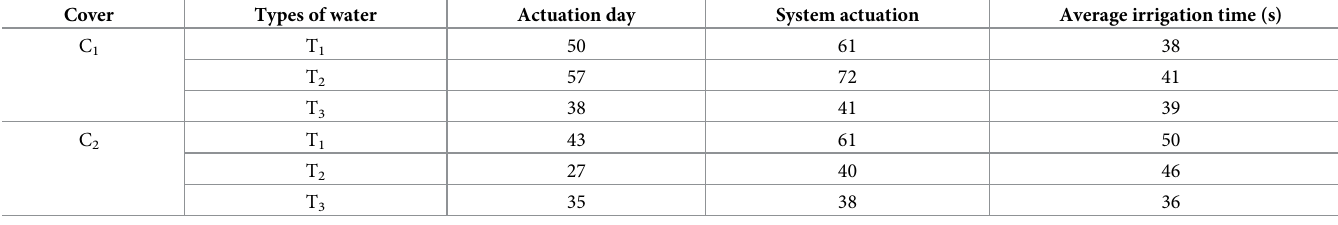
Table 2. Actuation of irrigation systems to produce D . nigra seedlings under different cover conditions and types of water. Cover Types of